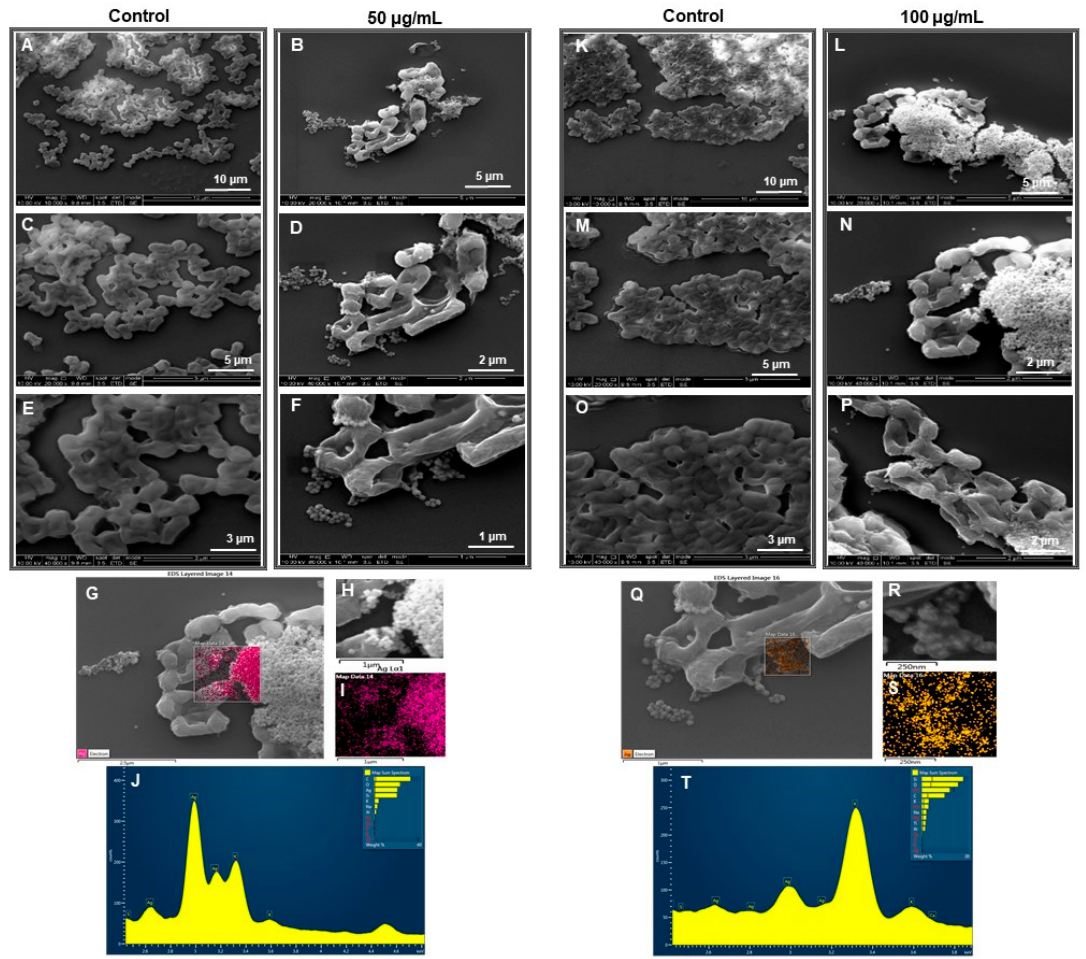
Figure 11. SEM analysis of E. coli cells after treatment with RB-AgNPs. ( A–F ) Control cells and RB-AgNPs treated cells with 50 µg/mL at different scales. ( G ) Scanned image of treated cells ( H , I ) elemental mapping of the selected area showing silver element in the treated cells, ( J ) EDX spectrum of the chosen area showing peak for silver element. ( K–P ) Control cells and RB-AgNPs treated cells with 100 µg/mL at different scales. ( Q ) Scanned image of treated cells ( R , S ) elemental mapping of the selected area showing silver element in the treated cells, ( T ) EDX spectrum of the chosen area showing peak for silver element.